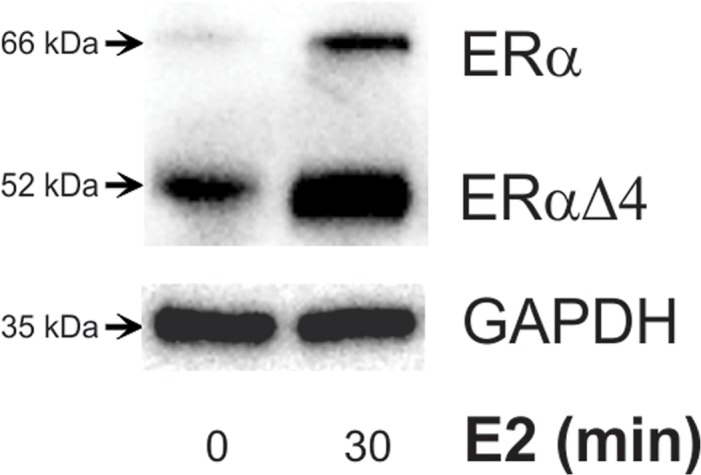
Cell surface biotinyation of N-38 cells treated with estrogen vs. control.Western blot analysis of biotinylated protein were probed with ERα to show: the 66 kDa band corresponding to the full-length ERα protein, and the 52 kDa band corresponding to a splice variant of ERα lacking exon 4 (ERαΔ4). The 52 kDa band is the primary ERα band detected in biotinylation/internalization experiments. Since both bands are regulated in parallel, ERαΔ4 was used as an indicator for both isoforms.